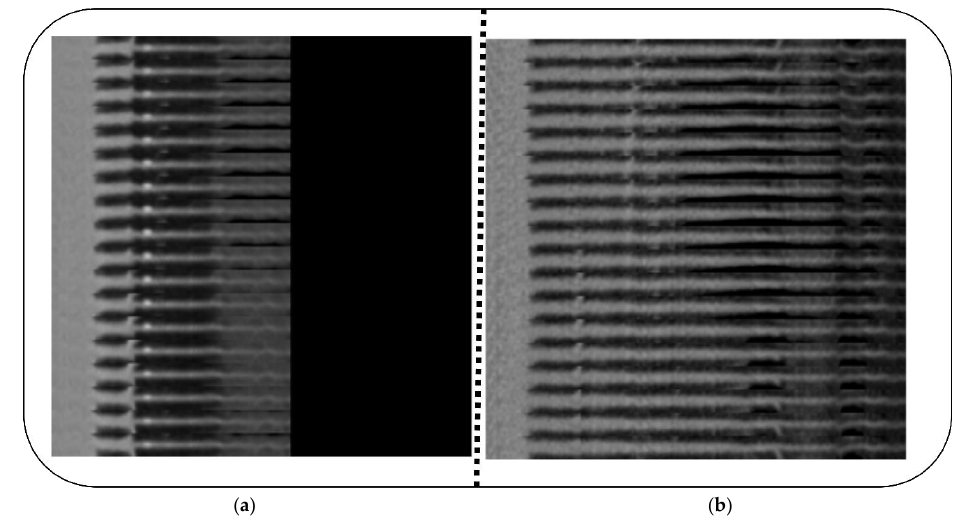
Figure 2. ( a ): Positive individual, ( b ): negative individual.